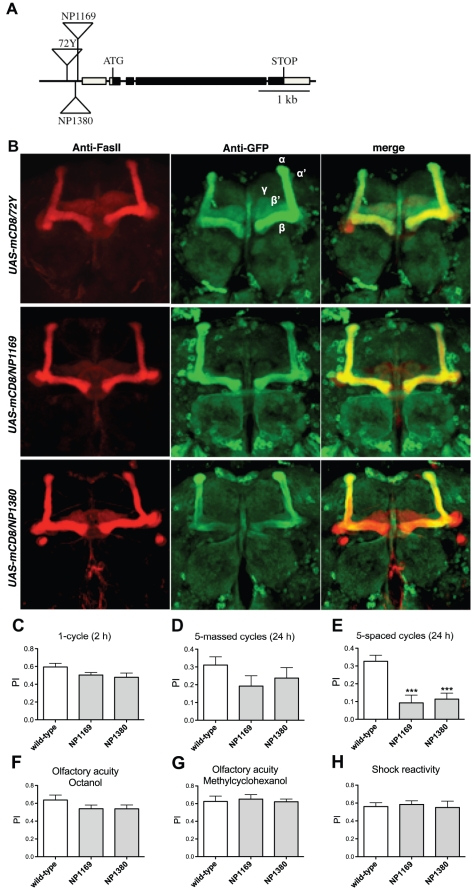
The dbr locus is specifically required for LTM.(A) Molecular map of the dbr locus. The 72Y P-element is inserted 353 bp upstream of the dbr transcriptional start site, those from the NP1169 and NP1380 lines are inserted 90 bp and 149 bp upstream of the dbr transcriptional start site, respectively. Boxes, genomic DNA corresponding to exons; black boxes, coding sequences. (B) 72Y, NP1169 and NP1380 enhancer-trap expression pattern. Freshly dissected brains from UAS-mCD8-GFP/72Y, UAS-mCD8-GFP/NP1169 and UAS-mCD8-GFP/NP1380 flies were incubated with anti-FasII antibodies to label the α/β and γ neurons (red), and anti-GFP antibodies (green). (C-H) NP1169 and NP1380 behavioral analysis. (C) STM analyzed 2 hrs after a single conditioning cycle is not affected (t test, p>0.05, n = 10). (D) ARM analyzed 24 hrs after five massed conditioning cycles is not affected (t test, p>0.05, n≥15). (E) LTM analyzed 24 hrs after five spaced conditioning cycles is impaired (t test, p<0.001, n≥11). Olfactory acuity for (F) octanol (t test, p>0.05, n≥14) and (G) methylcyclohexanol (t test, p>0.05, n = 8). (H) Shock sensitivity (t test, p>0.05, n = 9). Bars indicate mean ± SEM.